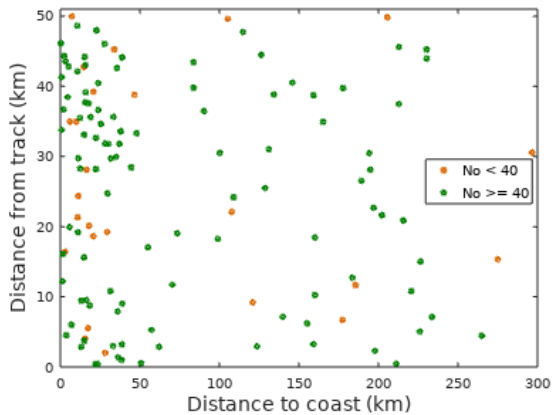
Figure 9. Contrasting measurements of distance from coast and distance from altimeter track. We only utilise those with at least 40 out of possible 73 Jason-3